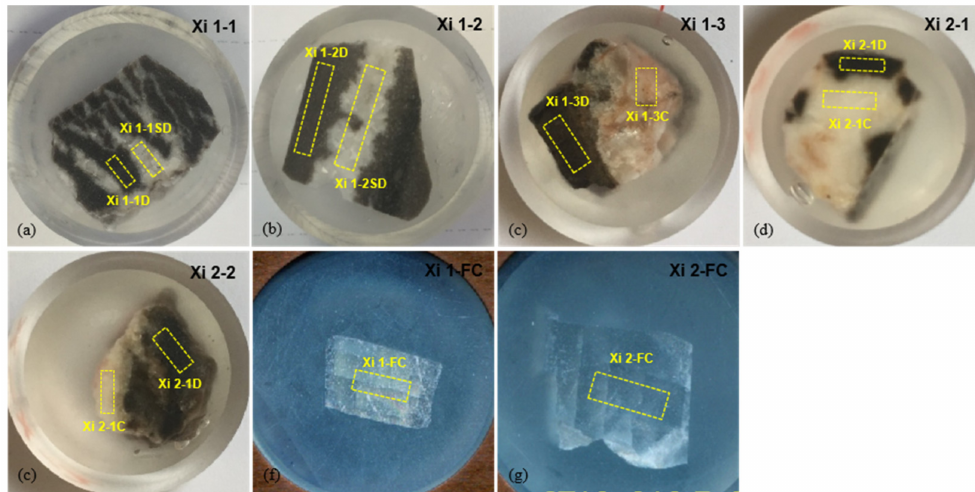
Figure 4. Photographs of sample target for U-Pb dating in Xiaoerblak Formation (the dotted boxes in the figure are the test points of different fabc): ( a ) Sample Xi 1-1; ( b ) Sample Xi 1-2; ( c ) Sample Xi 1-3; ( d ) Sample Xi 2-1; ( e ) Sample Xi 2-2; ( f ) Sample Xi 1-FC; ( g ) Sample Xi